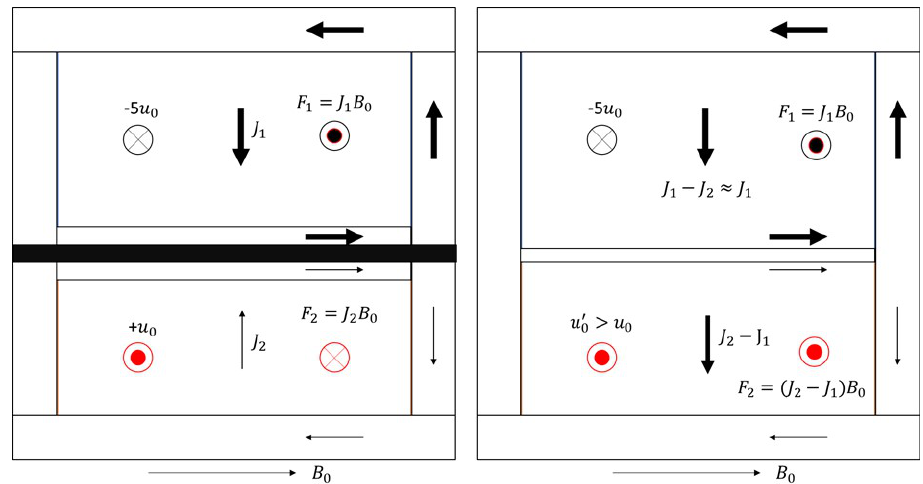
Figure 12. ( Left ) If the return ( top ) and Channel-1 ( bottom ) are not in electrical contact, i.e., separated by a thin layer of perfect electrical insulation (black band), no leakage currents can be exchanged and, in general, j 1 > j 2 due to the different flow rate. Lorentz force self-induced in the two channels opposes the flow movement. ( Right ) if the channels are in electrical contact, currents from the return channel can close through Channel-1 and induce a net promoting Lorentz force that increases the flow rate in it. The increase in average velocity eventually makes j 1 > j 2 and the balance is restored with the reappearance of a retarding Lorentz force in